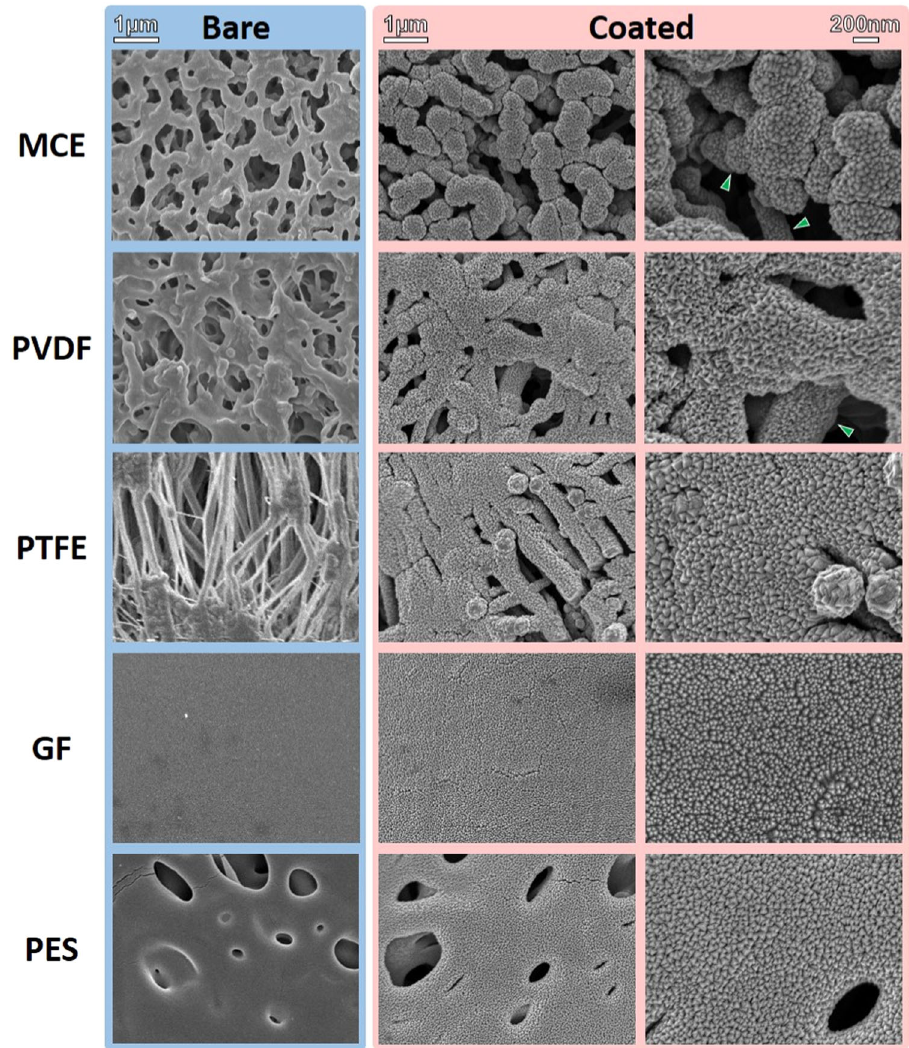
Fig. 1 Surface morphology of bare and coated membranes. Surface-view SEM micrographs showing bare and coated MCE, PVDF, PTFE, GF, and PES membranes. Green arrows in high-magni fi cation views of coated MCE and PVDF indicate relatively small nano-pyramidal SS structures below the membrane